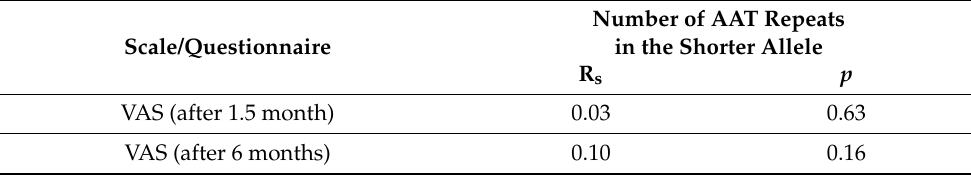
Table 9. The correlations between the number of AAT repeats in the CNR1 gene in the shorter allele, pain intensity, hip function, and the degree of disability in patients at defined